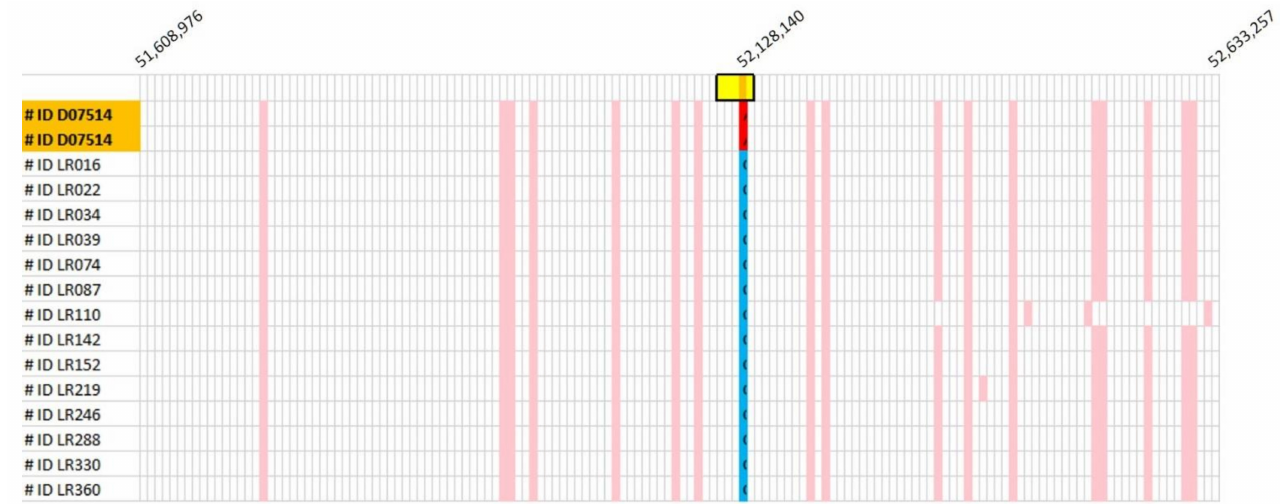
Figure 3. Examples of haplotypes encompassing the EHBP1L1 gene. Haplotypes were generated from 144 SNPs within 1 Mb flanking the EHBP1L1 gene. The gene location is denoted by a bolded yellow box at the top. Each row represents a haplotype obtained from the dog identified on the left. Each cell represents a SNP and the CFA18 positions of the 5 (cid:48) and 3 (cid:48) SNPs are indicated at the top; the mutation position is also indicated. The haplotype (highlighted in orange) that contains the EHBP1L1 mutation (highlighted in red) is present as two copies (i.e., two rows) in the case. An identical 144 SNP haplotype was found as a single copy in twelve of the controls. These haplotypes were subsequently shown to differ from that in the case by having a reference allele (denoted as blue). Several other haplotypes containing a segment of the affected haplotype were also observed in the controls. These haplotypes also contained the reference